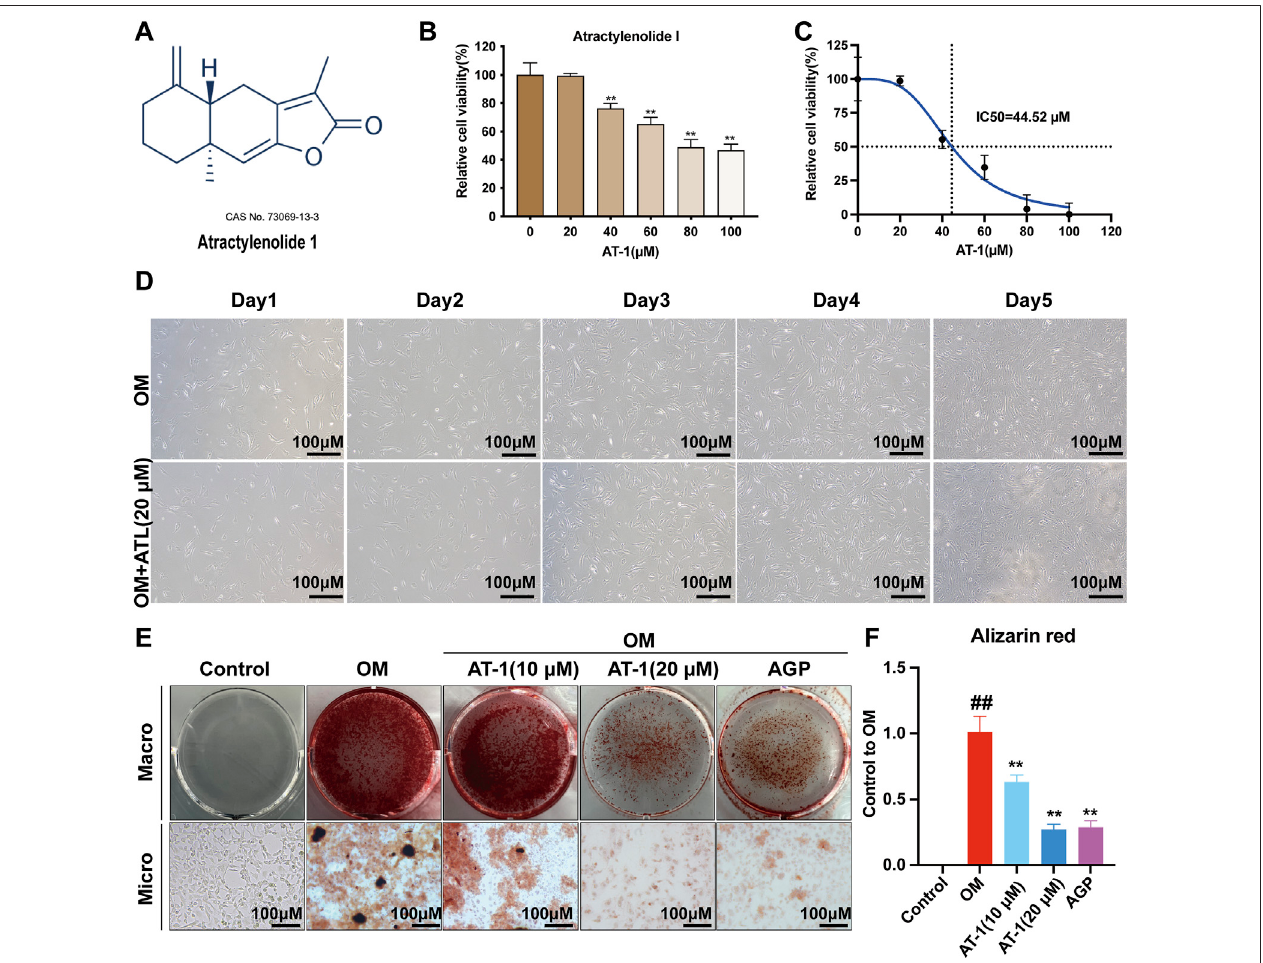
FIGURE1| Viabilityandcalci fi cationofVICstreatedwithAT-1. (A) Chemicalstructureofatractylenolide-1. (B) TheCCK8methodwasusedtoanalyzetheeffectof treatment with different atractylenolide-1 concentrations on VICs. (C) IC50 of atractylenolide-1 in VIC cells. (D) Effect of no AT-1 and 20 μ M AT-1 on the proliferation of OM-induced VIC cells in 5 days. (E) Cells with different treatments (control (normal culture medium), OM (osteogenic medium), OM+10 μ M AT-1 (osteoblastic medium plus10 μ M AT-1 treatment), OM+20 μ M AT-1 (osteoblastic medium plus 20 μ M AT-1 treatment), and OM + AGP (osteoblastic medium plus 10 μ M andrographolide) were stained with Alizarin Red S. (F) Alizarin Red staining statistics. * p < 0.05, ** p < 0.01 indicated a signi fi cant difference compared to the control group and # p < 0.05, ## p < 0.01 indicated a signi fi cant difference compared to the OM group, n = 3.